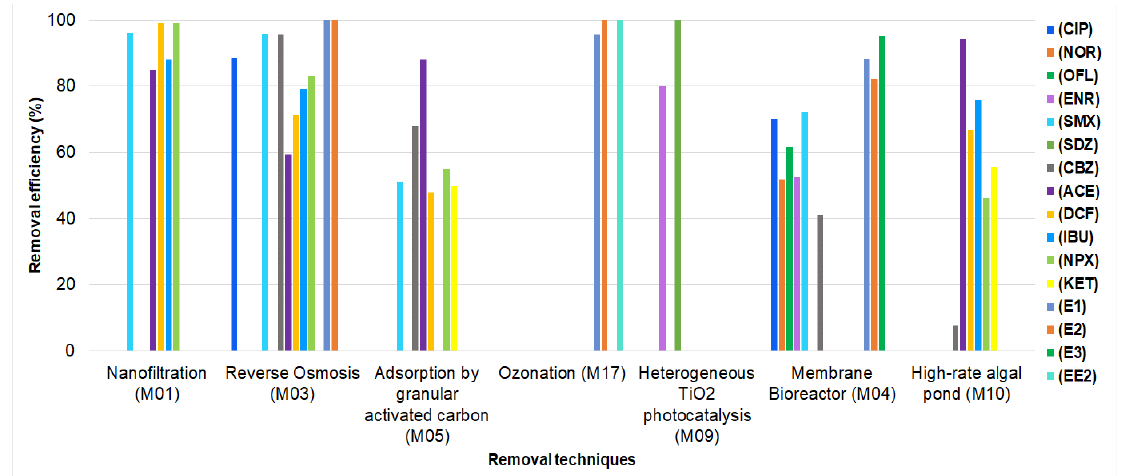
Figure 6. Removal of pharmaceuticals from municipal wastewater in studies with a quasi-experimental design (M01 = [27], M03 = [29], M05 = [31], M17 = [49], M09 = [35], M04 = [30], M10 = [36]).